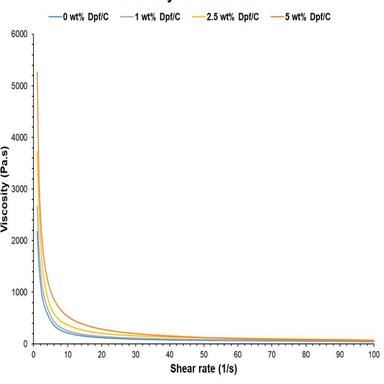
Line graph depicting the viscosity variation vs shear rate for different Dpf/C ratios.